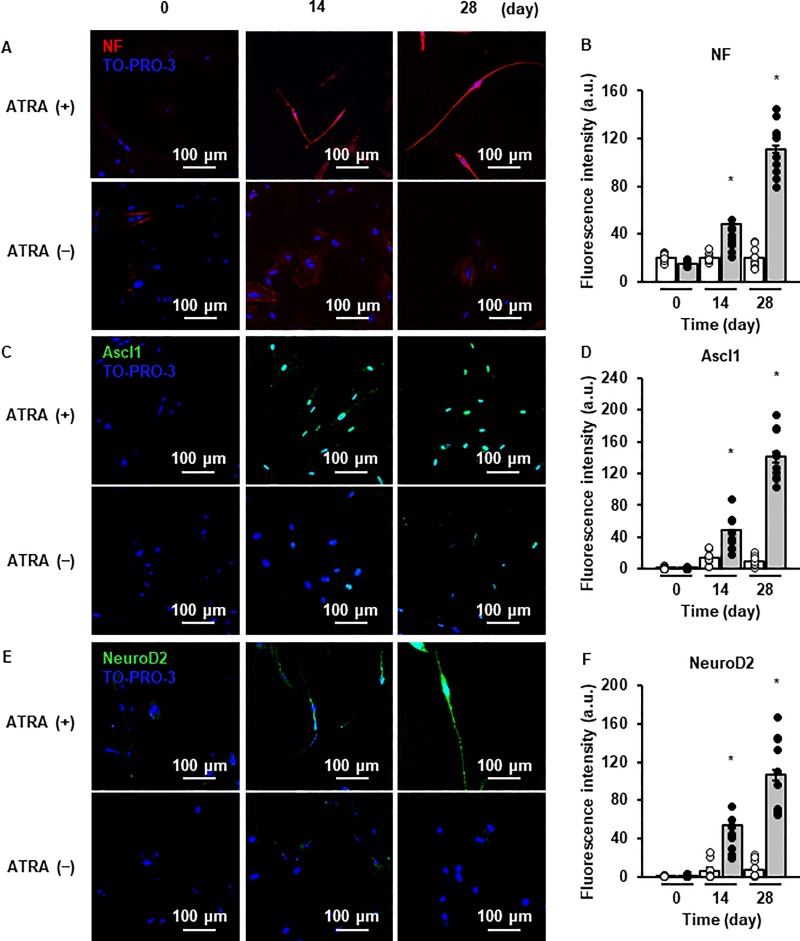
Immunocytochemical analysis of the localization of neuronal marker proteins.Representative images and fluorescence intensity of the cellular localization of NF-H (A and B), Ascl1 (C and D), and NeuroD2 (E and F) of DFATs (n = 10 cells, random selected ×20 fields from triplicate samples), with (upper panels) or without (control; lower panels) ATRA treatment after 0, 14, and 28 days. Data are shown as the mean ± standard error of three independent experiments. *P < 0.05, compared with 0 day.